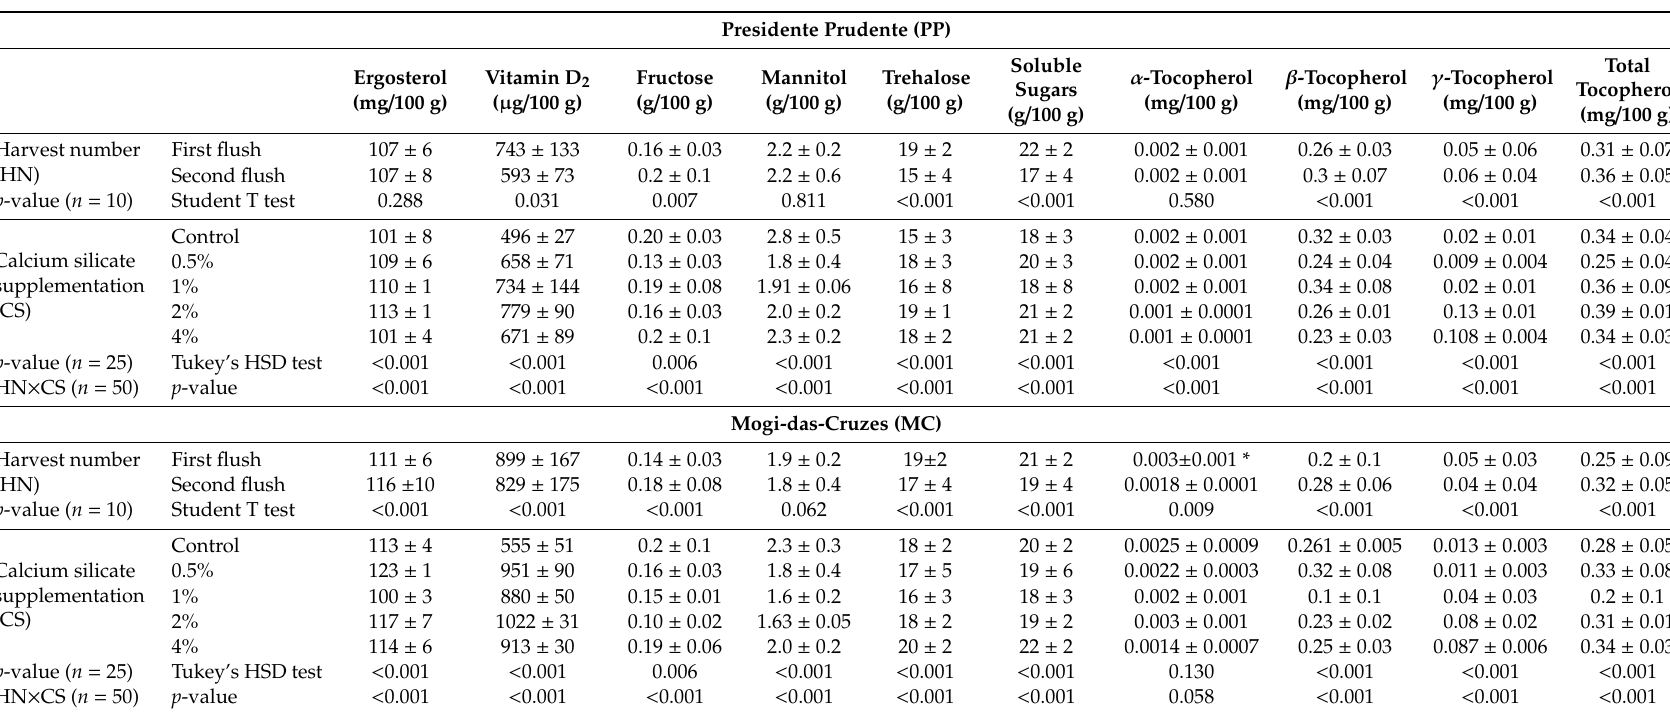
Table 2. Di ff erent bioactive compounds and soluble sugars detected in the two mushroom strains along the two harvests and CS supplementation